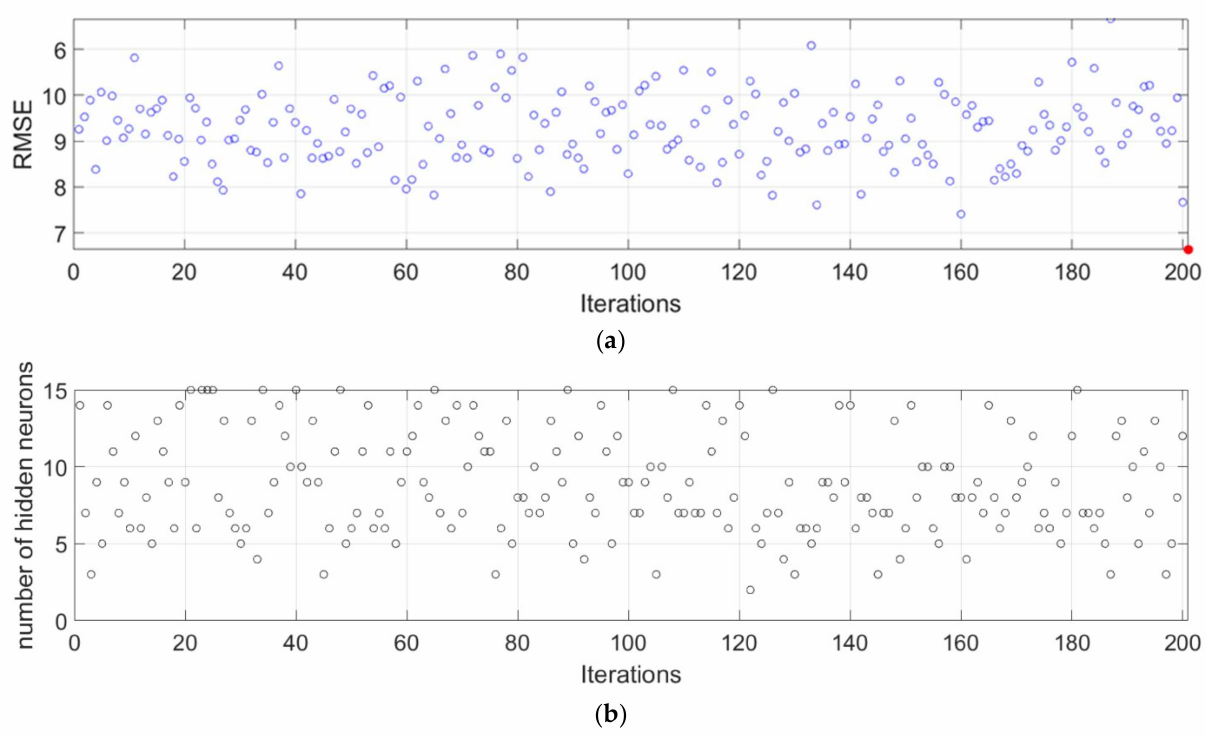
Figure 20. ( a ) RMSE value for each of the iterations; and ( b ) the optimal number of neurons in the hidden layer in each of iteration.